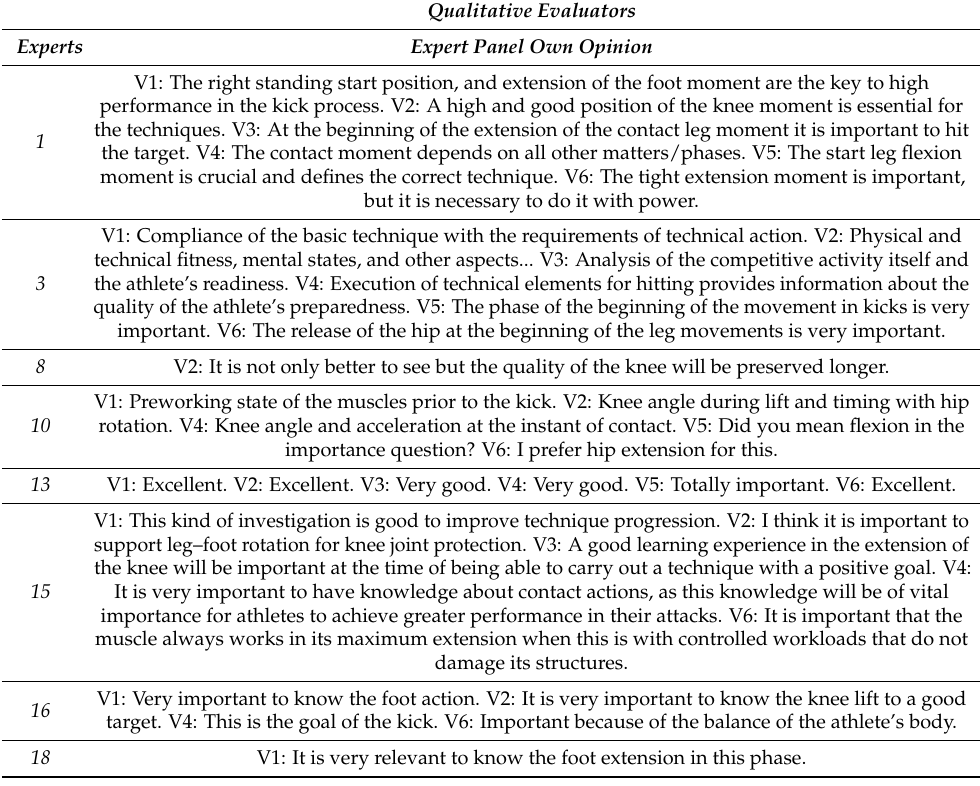
Table 7. Qualitative evaluations provided by the expert panel.